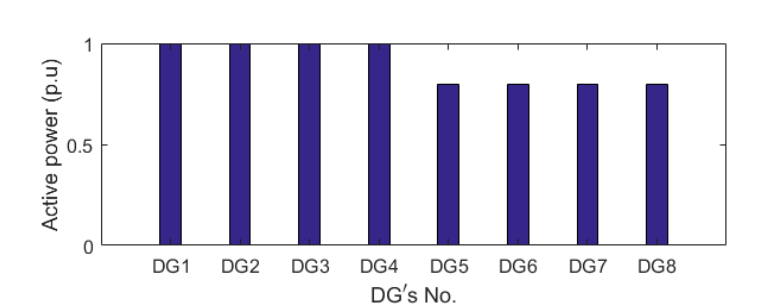
(b) Figure 5. ( a ) Reactive power output; and ( b ) node voltage of distributed generators with different methods when the output of each DG is set as shown in Figure 4 and all loads are set to 0 p.u.